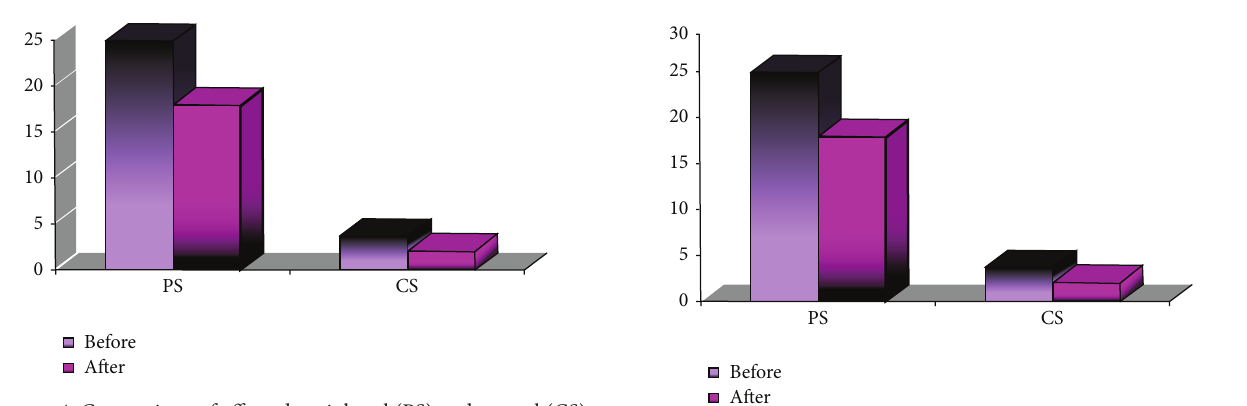
Figure 4: Comparison of affected peripheral (PS) and central (CS) segments before and after treatment in group A.